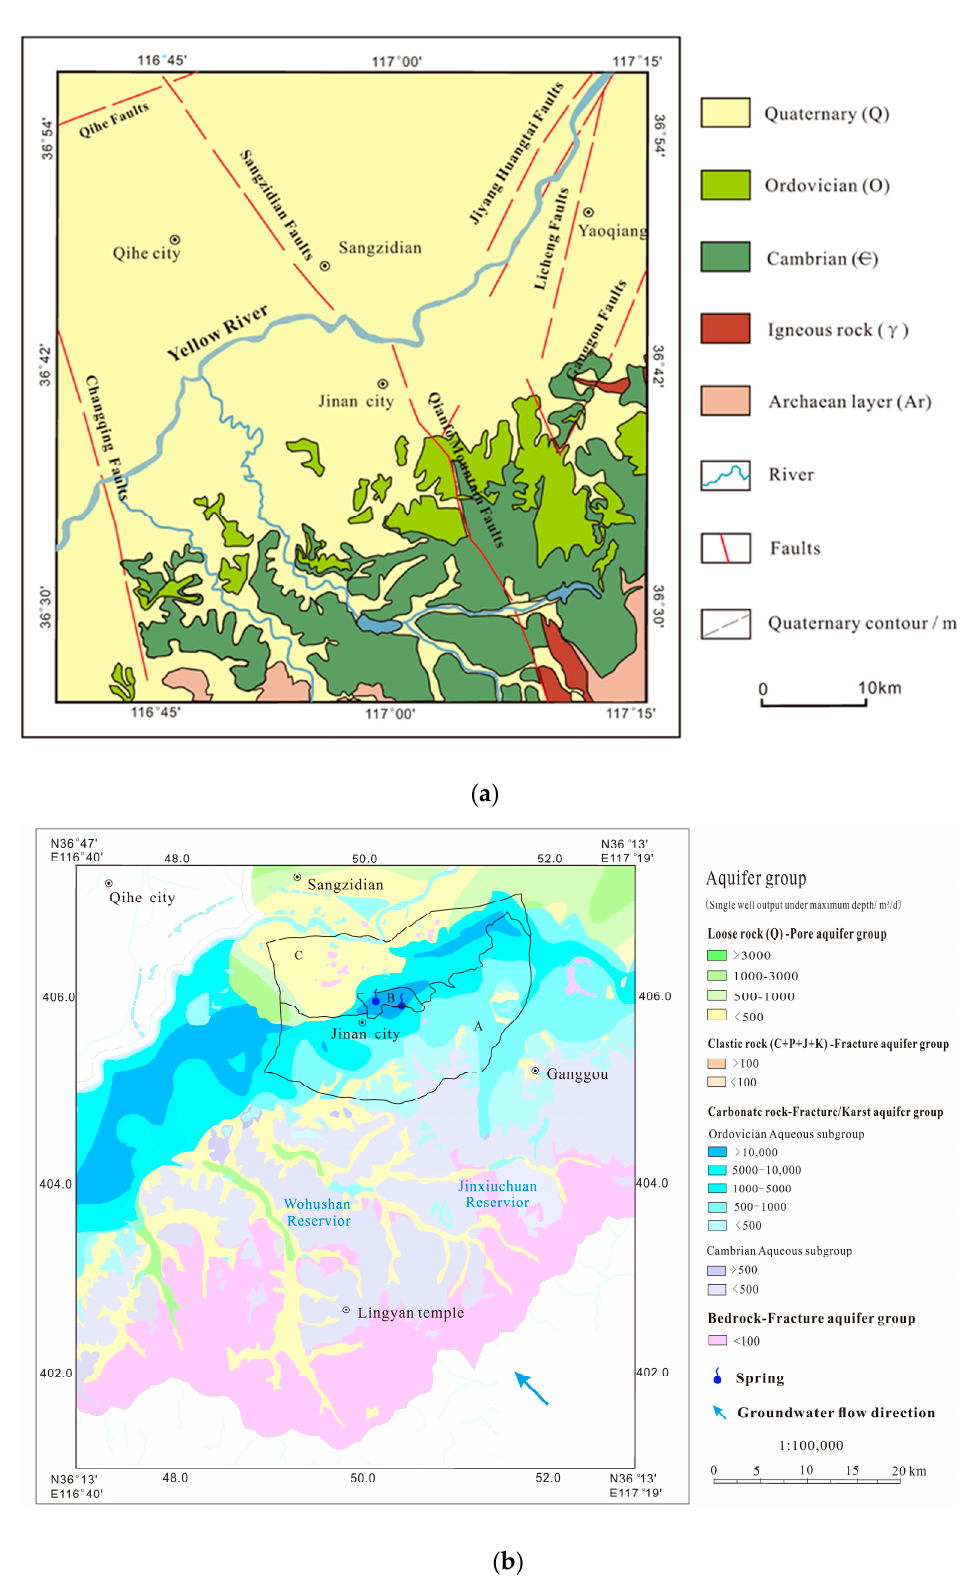
Figure 2. The geological profile ( a ) and hydrogeological profile ( b ) of the springs field in Jinan.